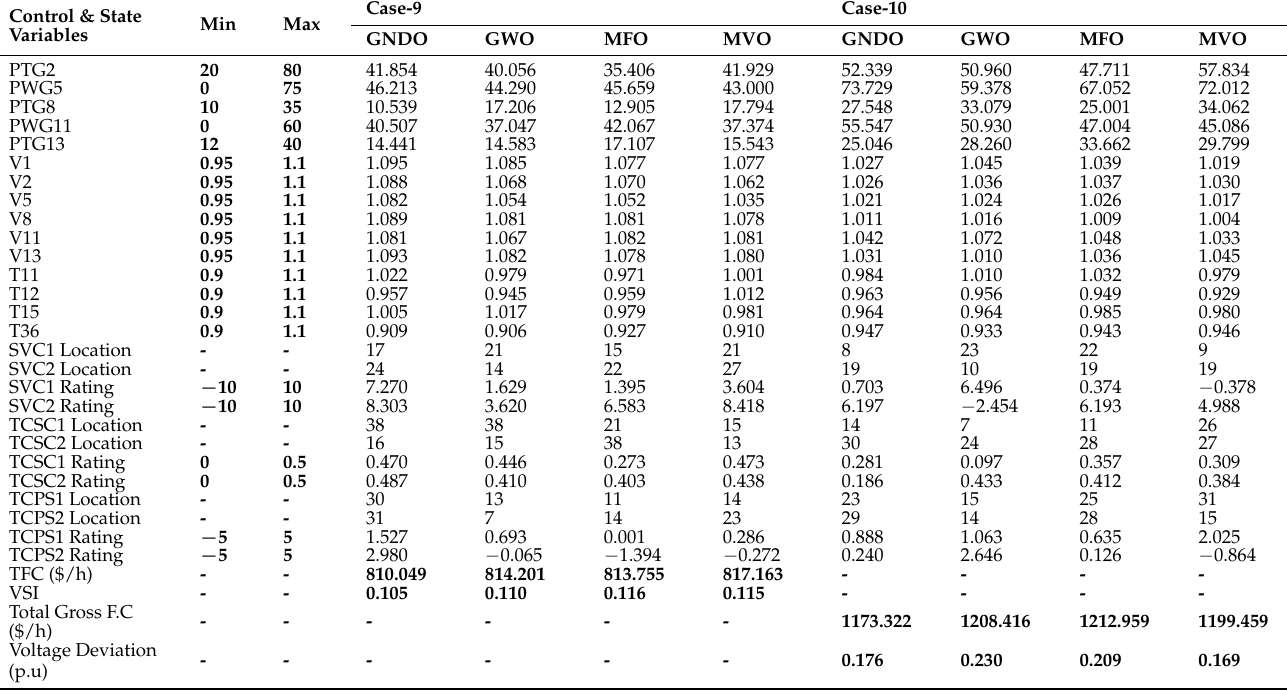
Table 14. Multi-objective simulation results for case 9 and case